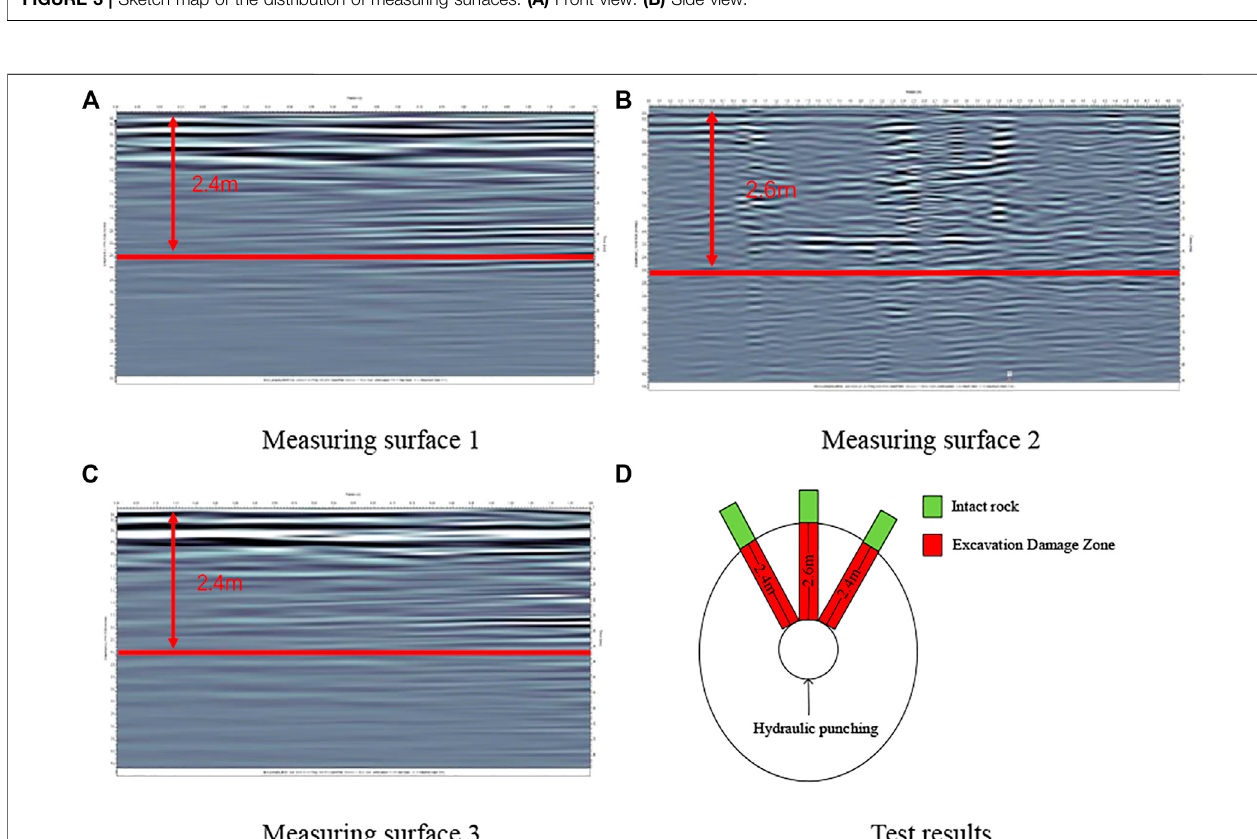
FIGURE 3 | Sketch map of the distribution of measuring surfaces. (A) Front view. (B) Side